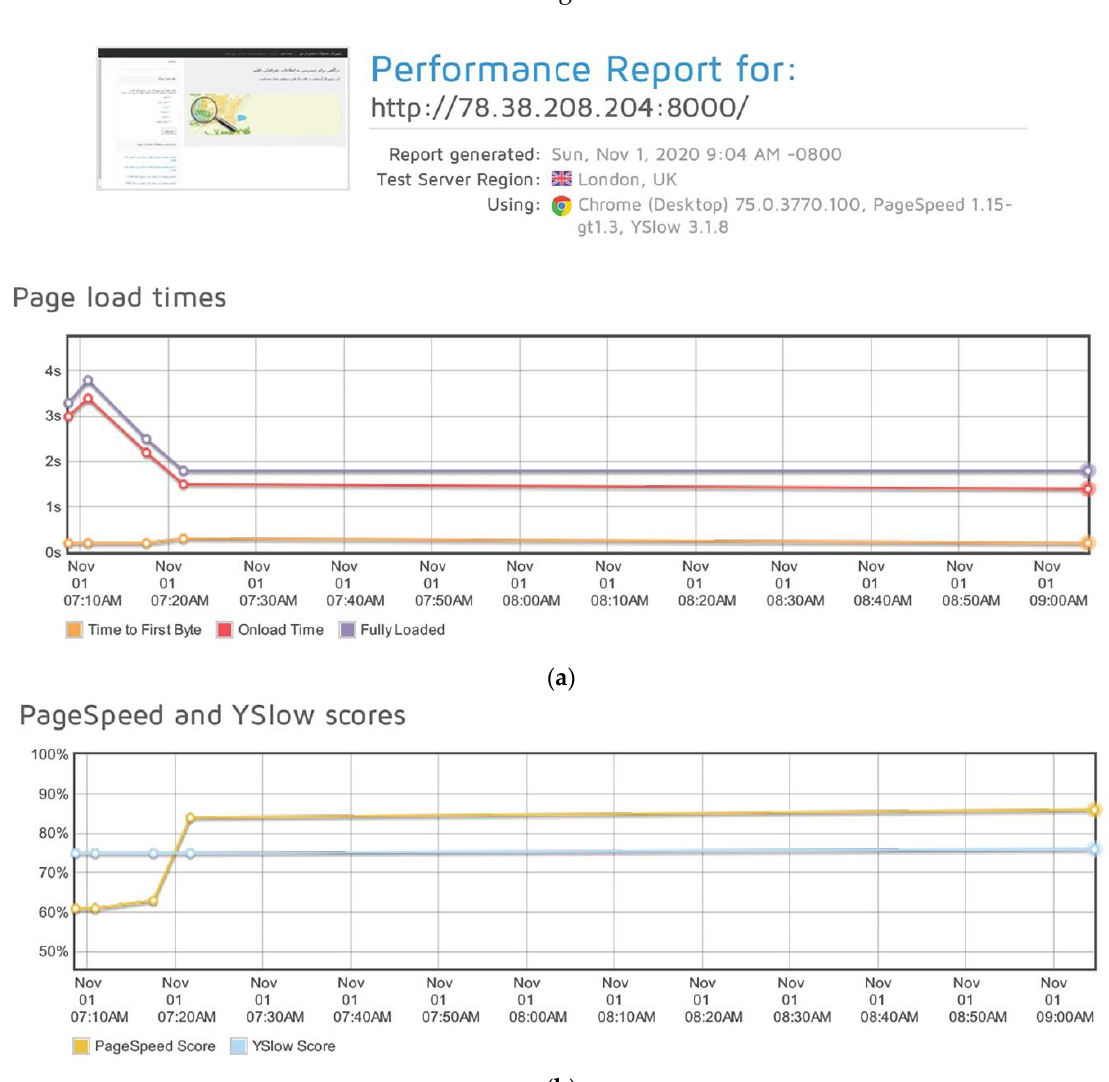
Figure 15. Analysis of the performance of the prototype system using GTmetrix tool based on ( a ) page load times and ( b ) speed scores.